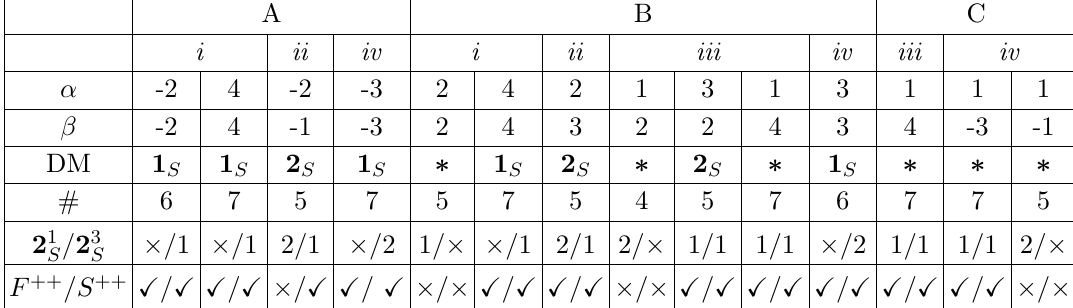
Table 5. The same as in table 2 for diagram 1.d of (cid:12)gure